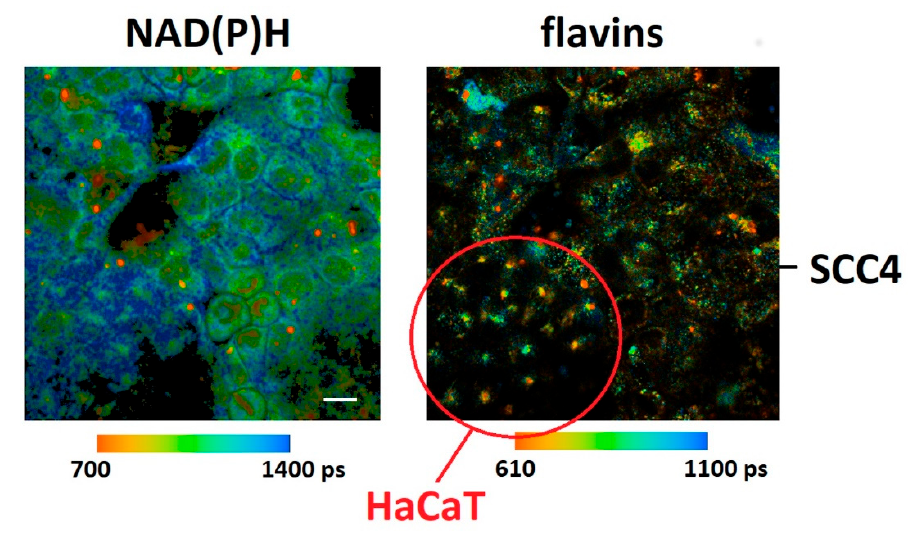
Figure 4. Fluorescence lifetime images of co-cultured HaCaT and SCC4 cells. The autofluorescence of NAD(P)H was recorded in the “green” (426–446 nm) spectral channel under 780 nm two-photon excitation whereas the autofluorescence of flavins was collected in the “red” (542–582 nm) spectral channel under 880 nm two-photon excitation. Scale bar 20 µm. Table 6. Mean fluorescence lifetime, metabolic index and FLIRR1 for NAD(P)H and flavins within co-cultivated HaCaT and SCC4 cells. NAD(P)H fluorescence decay was fitted biexponentially with